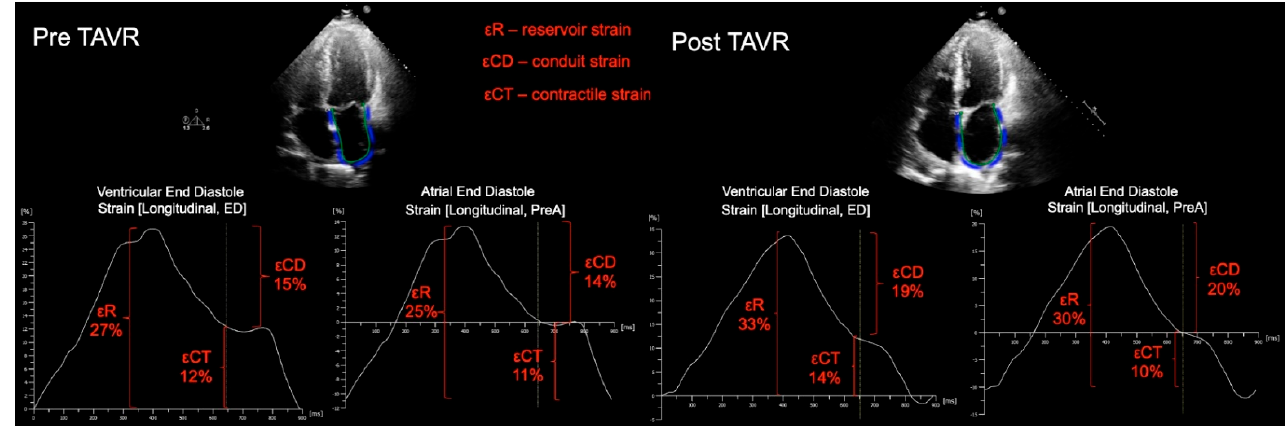
Figure 1. Representative example of LA strain measured for a patient prior to, and following TAVR, showing improvement in LA phasic function. For LA strain analysis, apical 4-chamber and 2-chamber views were used (4-chamber views only shown); the LA endocardial border was manually traced, generating a region of interest (ROI). Following segmental tracking and manual adjustment of the ROI, the software package generated longitudinal strain curves. LA strain was measured with the zero-reference standard at end-diastole and at the onset of atrial contraction. Reservoir function ( ε R), (strain value at mitral valve opening—ventricular end-diastole), LA conduit function (strain at onset of atrial contraction—strain at mitral valve opening) and contractile function ( ε CT) (strain at ventricular end-diastole—strain at onset of atrial contraction) were then derived.